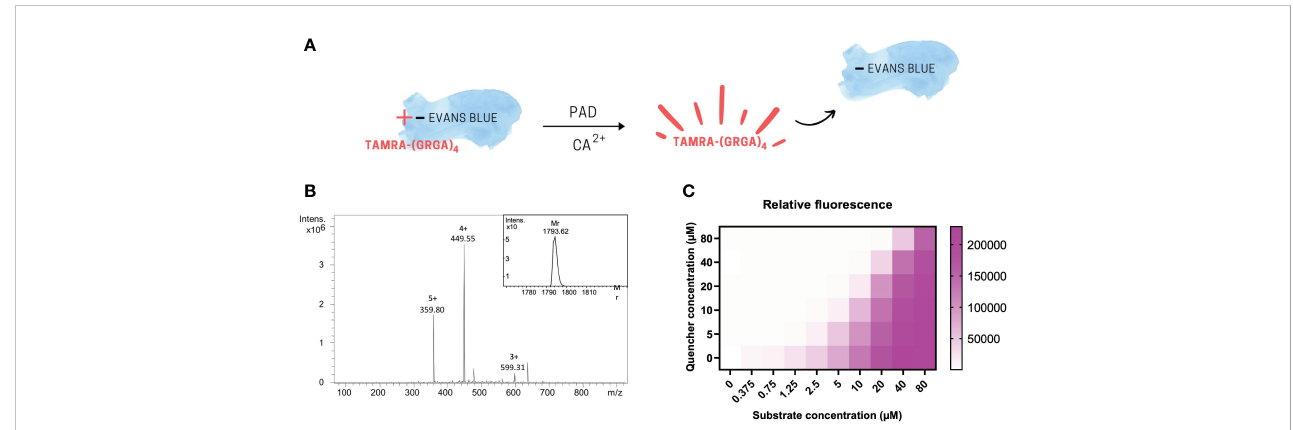
FIGURE 1 The PAD substrate TAMRA-(GRGA) 4 is dose-dependently quenched by Evans Blue. Graphical scheme of fl uorescence quenching principle (A) . After chemical synthesis of the fl uorescent probe, the quality of the synthesized substrate TAMRA-(GRGA) 4 was validated by ion trap mass spectrometry (B) . The experimentally determined relative molecular mass of 1793.62 was calculated from the multiple charged ions of the mass spectrum using Bruker deconvolution software and shown as insert on the unprocessed mass spectrum showing the multiple charged ions in panel (B) Quenching of TAMRA fl uorescence was achieved in a dose-dependent manner by addition of Evans blue (C)